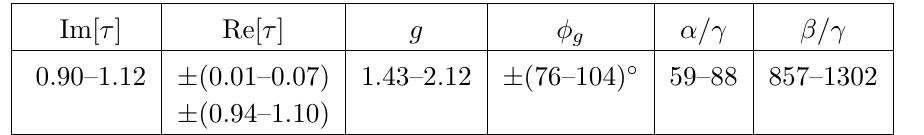
Table 5 . The parameter regions consistent with the experimental data of table 3 for model III. Results do not change under the exchange of (cid:11)=(cid:13) and (cid:12)=(cid:13)